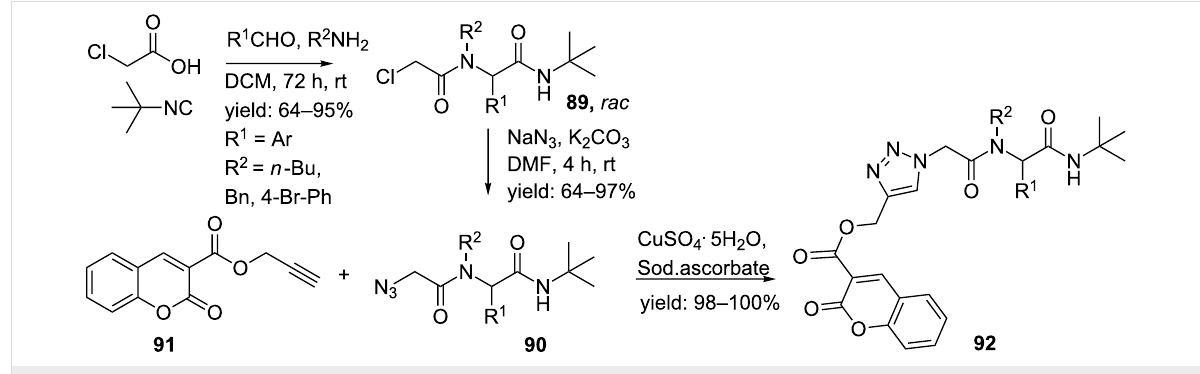
Scheme 28: The Ugi/Click-approach by Pramitha and Bahulayan.